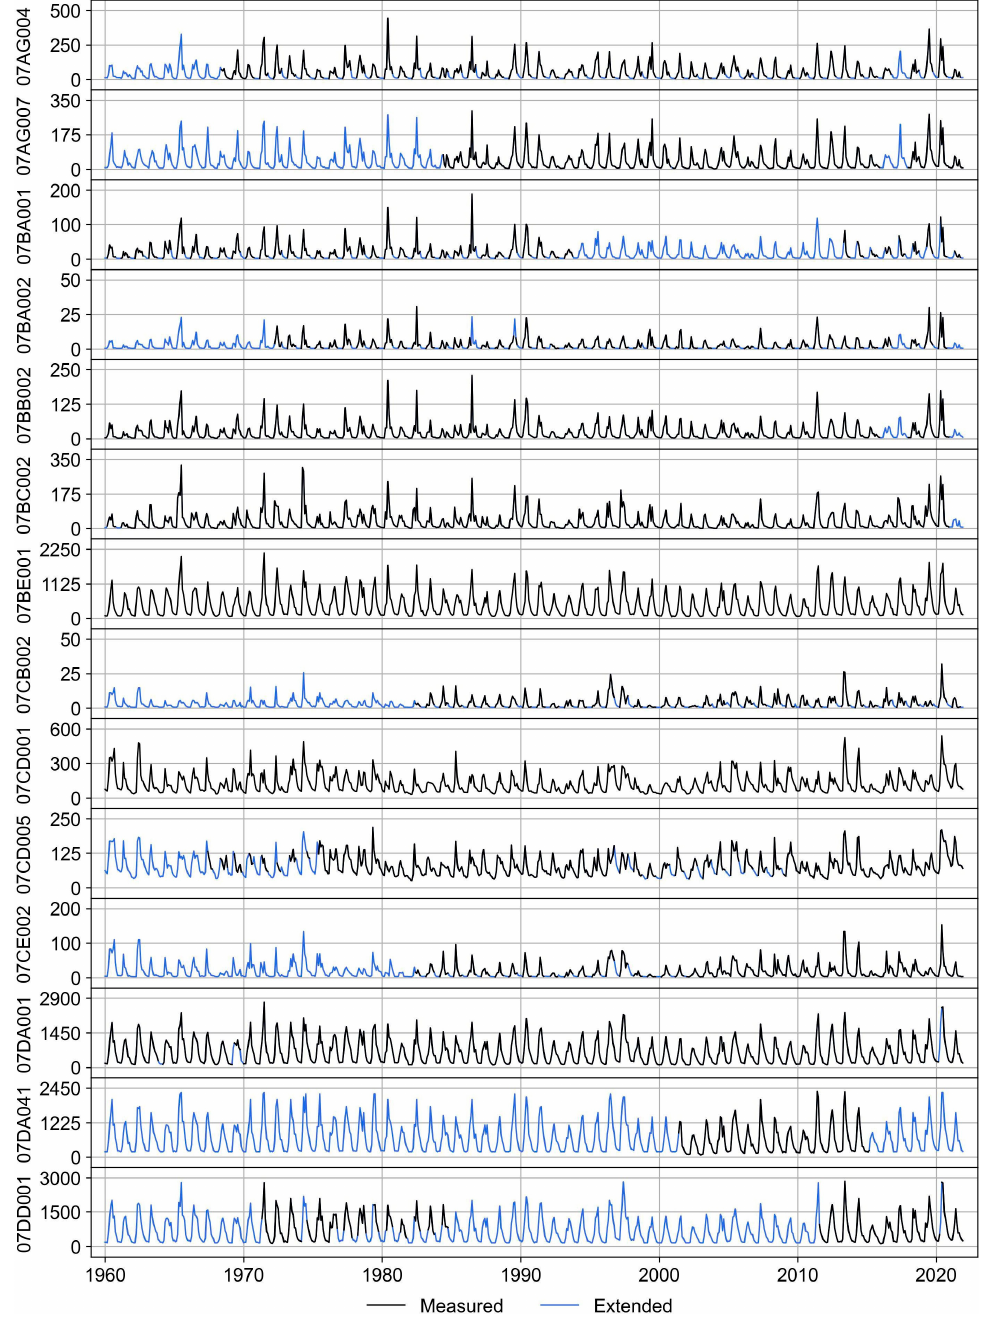
Figure 4. The measured (solid black line) and extended (solid blue line) monthly streamflow (m 3 /s) time series through various regression (solid blue line) modeling Part 2.